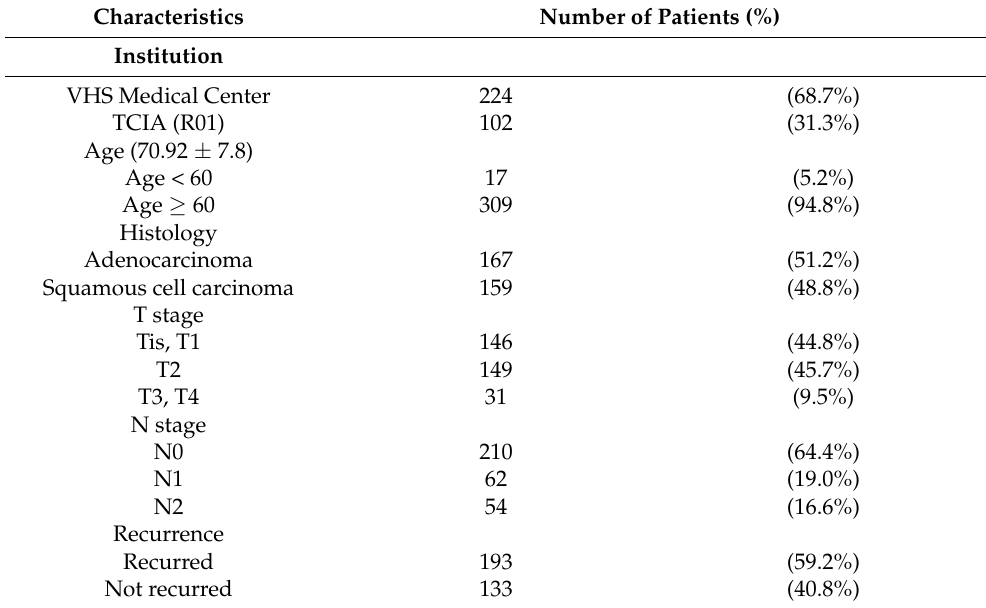
Table 1. Demographic characteristics.